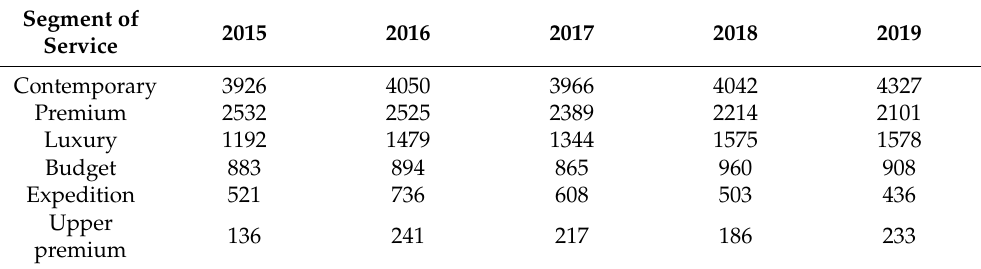
Table 2. Number of cruise calls by segment of service registered in the ports of the sample during the period 2015 to